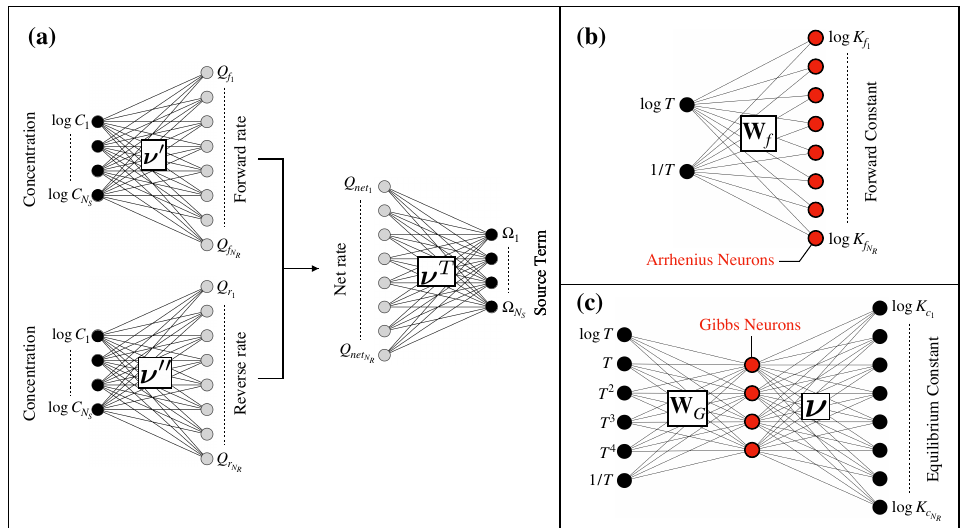
Figure 1. Illustrations of ANN-based formulations for N C = 1, N S = 4, and N R = 8. Since N C = 1, input/outputs are vectors and cell indices are ignored. ( a ) Schematic of Equations (2) and (4). Exponential activation functions are used to produce forward/reverse rates. ( b ) Schematic of Arrhenius layer for forward rate constant (Equation (6)), which is interpreted as a bias term for the output of the forward rate layer in ( a ) (see Equation (4)). ( c ) Schematic of Gibbs layer equilibrium constant (Equation (11)). The schematics in both ( b , c ) produce the logarithm of the reverse rate constant, which is interpreted as a bias term for the output of the reverse rate layer in ( a ) (see Equation